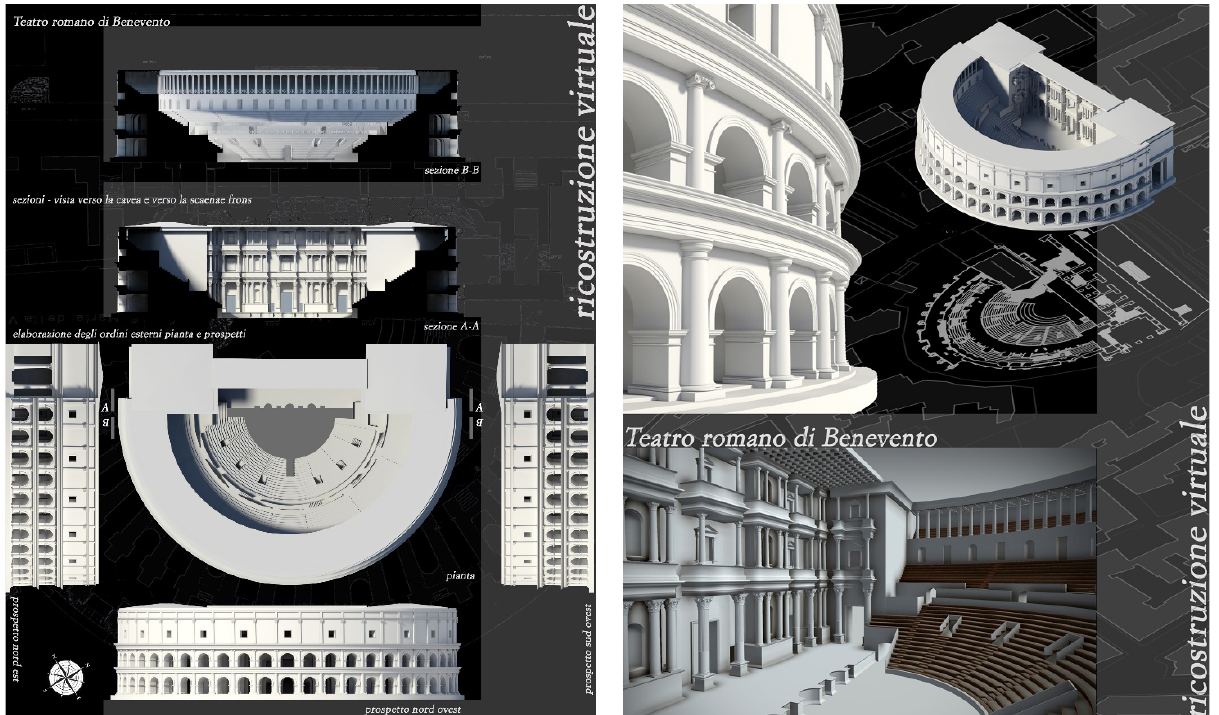
Figur e 10: 3d model of the reconstructive hypothesis of the theatre of Benevento.